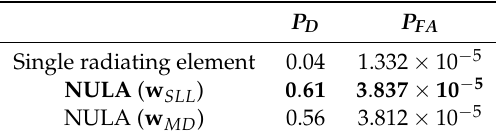
Table 10. Detection performances evaluated for the controlled